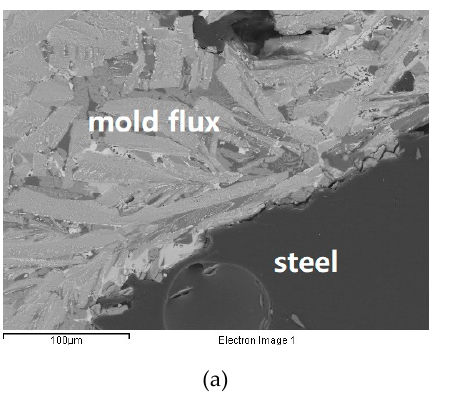
Figure 9. Morphology of original slag: ( a ) full view; ( b ) details of Part III.